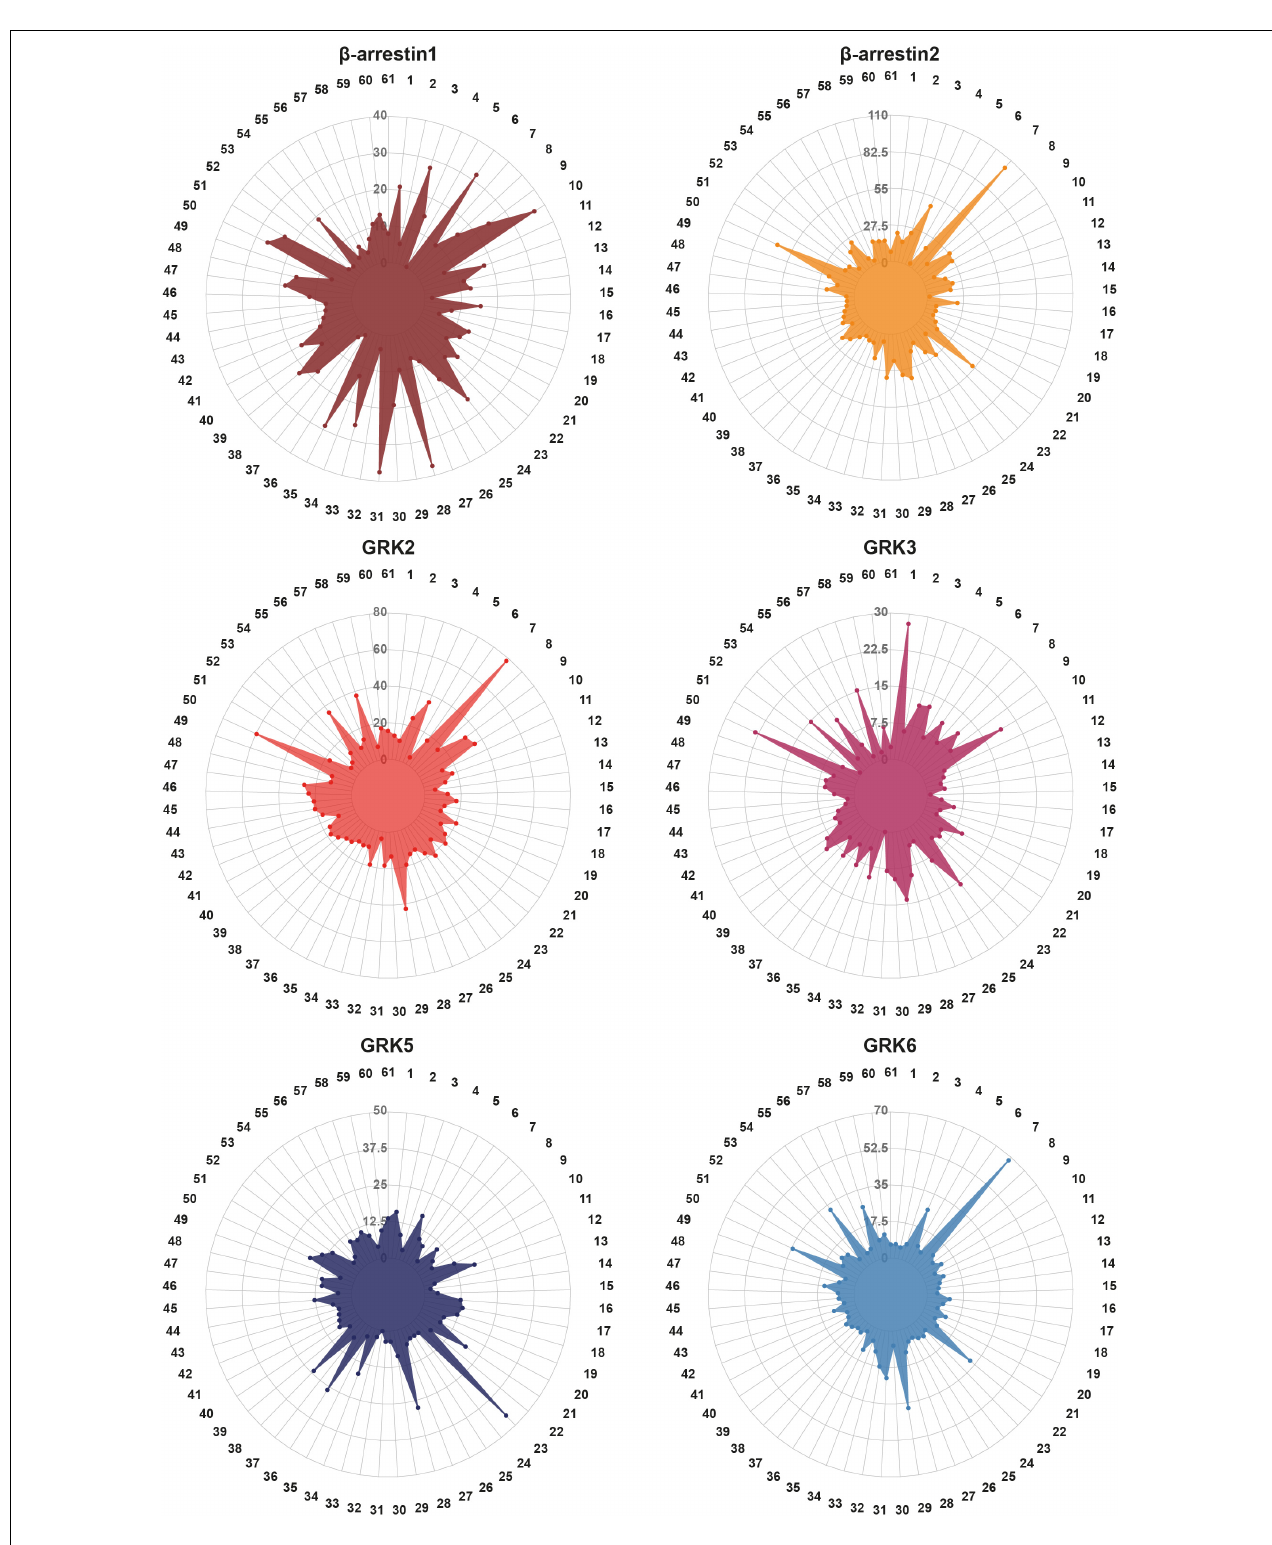
FIGURE 3 | Visualization of the tissue-specific expression levels of GRK2, 3, 5, and 6, β -arrestin1 and -2. The consensus expression data of Table 1 are visualized in radar plots for each protein in 61 tissues. The numbers correspond to the assigned indices of tissues in Table 1 . The data are based on the Human Protein Atlas version 20.1 (https://www.proteinatlas.org/), last accessed March 10th, 2021.